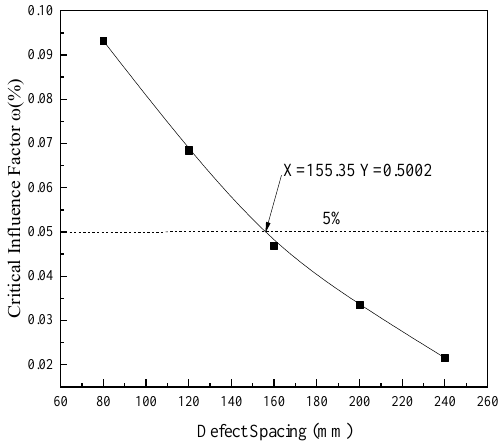
Figure 2. Example of the critical distance calculation.